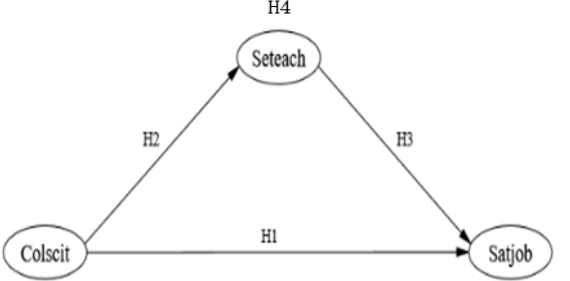
Figure 1. A hypothetical model relating science teacher job satisfaction, teacher collaboration, and instructional self-efficacy.